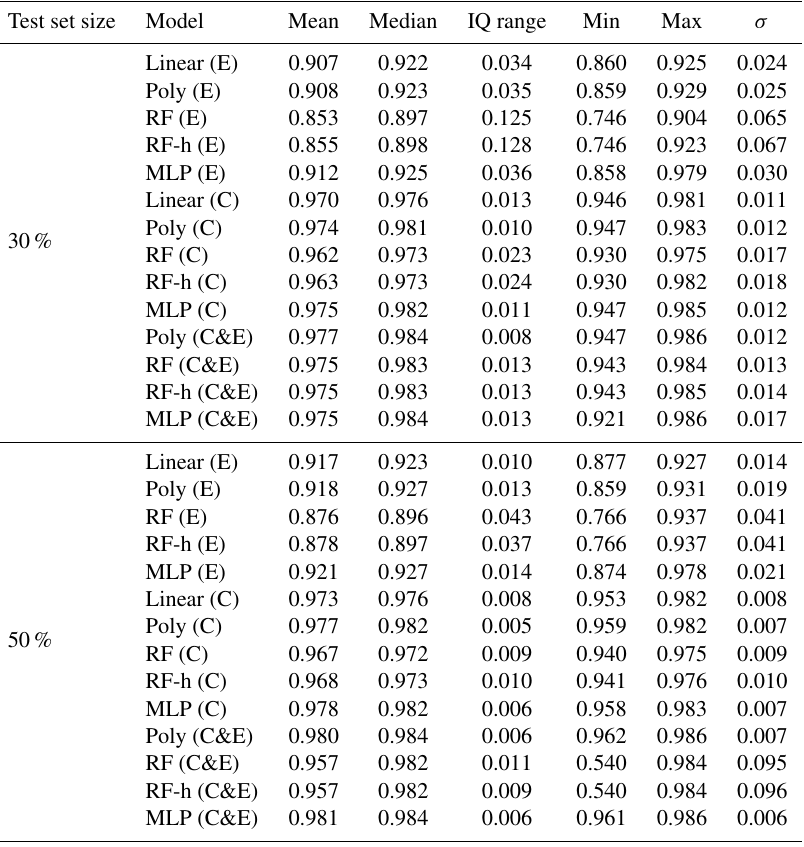
Table A5. Summary statistics of the Pearson correlation coefficient ( ρ ) distributions between models on the test set for a 20-fold cross- validation. The inputs of the modes are only voltage from the Figaro ® TGS